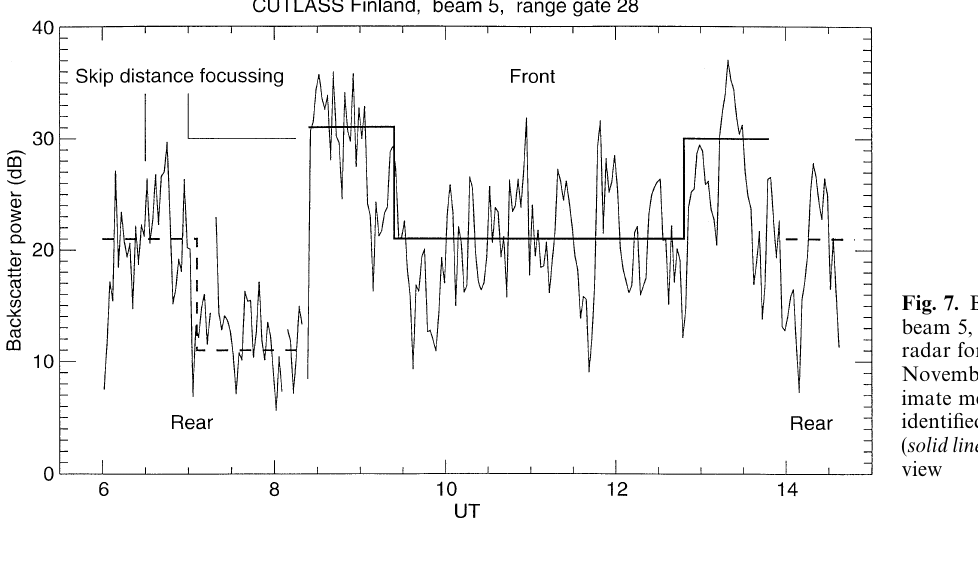
Fig. 6. a Backscatter power RTI plot for beam 5 of the Finland radar for 25 November 1995. Bars at the top of the panel indicate the daytime interval during which ground backscatter from the front ( thick bar ) and rear ( thin bar ) fields-of-view is observed. b Similar to a except for beam 7 of the Iceland radar. c Elevation angles deter- mined for 0500 UT to 0930 UT for the Finland radar for 25 Novem- ber 1995 assuming backscatter originates from the front field-of- view. d Similar to c except assuming backscatter originates from the rear